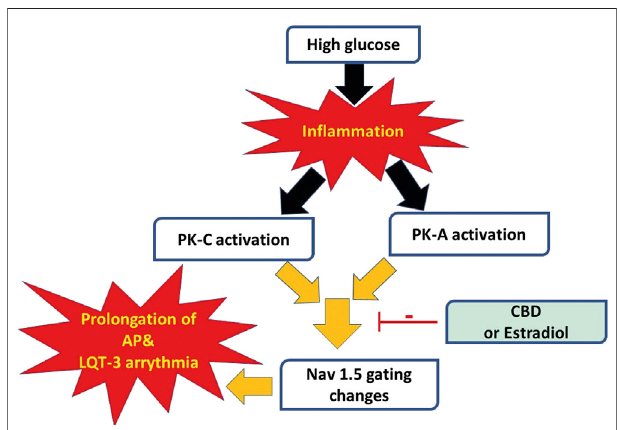
FIGURE 8 | A schematic of possible cellular pathway involved in the protective effect of CBD, E 2 against high glucose induced in fl ammation and activation of PK-A and PK-C via affecting cardiac voltage-gated sodium channels